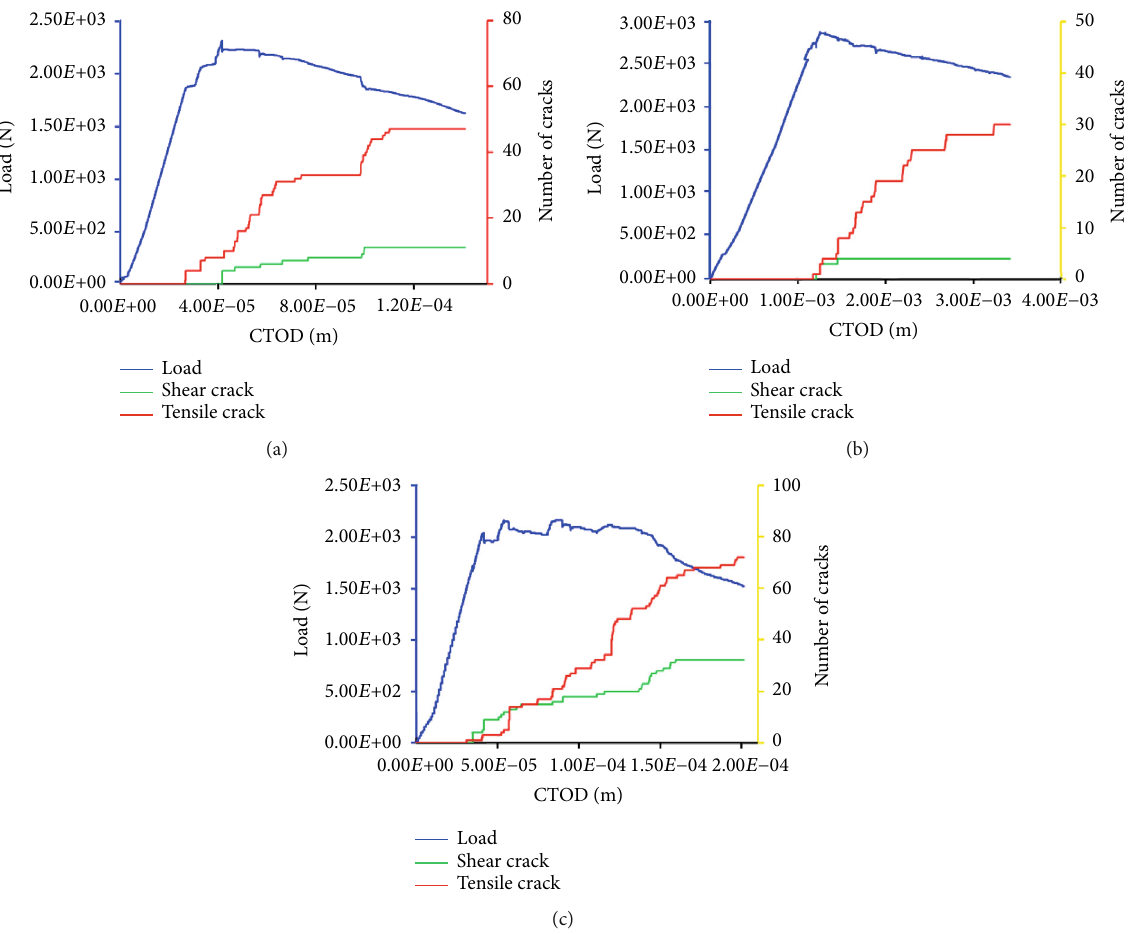
Figure 12: Curve of fracture toughness simulation test results. Shown in the fi gures are the curves of the variable (the load and the crack number) with the crack tip opening displacement (CTOD) of the three sets of experimental. The blue lines are the load. The green lines are the number of shear cracks. The red lines are the number of tensile